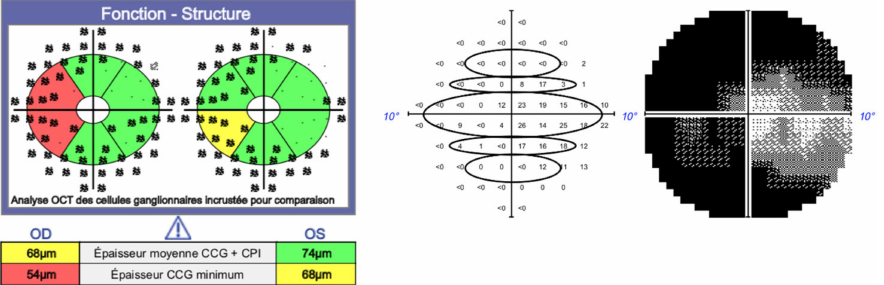
Figure 1. Investigation of structure–function correlations using the software GPA II and Cirrus. The visual field testing areas have to be moved to overlap with the corresponding areas in the ganglion cell maps, as described by Hood and Raza. The black circles show the points of sensitivity in the 10-2 visual field map we used for the analysis. OCT: ocular coherence tomography; OD: right eye; OS: left eye; CCG: ganglion cell complex; CPI: inner plexiform